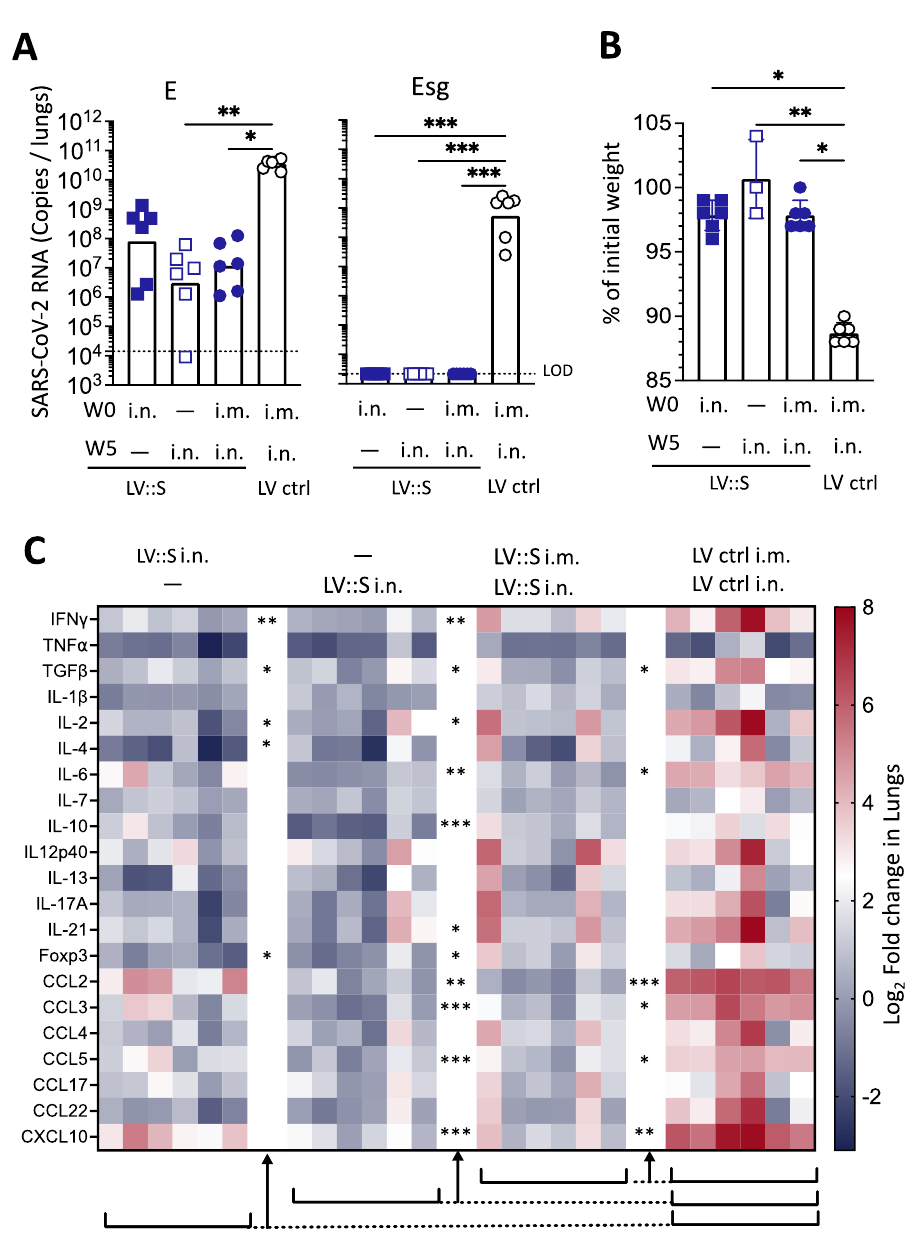
Figure 3. Single i.n. LV::S injection fully protects hamsters against WA1 SARS-CoV-2. Hamsters are those described in the legend to Figure 2. Hamsters were immunized either i.n. with 1 × 10 8 TU of LV::S at wk0 (blue squares) or wk5 (open squares) or i.m. at wk0 and i.n. at wk5 (blue circles). Black circles represent hamsters injected i.m. at wk0 and i.n. at wk5 with 1 × 10 8 TU of LV::ctrl. ( A ) Lung viral loads quantitated by total E ( left ) or Esg qRT-PCR ( right ) at 4 dpi. Bars represent geometric means. ( B ) Percentages of weight loss in LV::S- or LV ctrl-vaccinated hamsters at 4 dpi. ( C ) Expression of inflammatory cytokines in lung tissues after challenge. The heatmap recapitulates relative log 2 fold changes in the expression of inflammation-related mediators in LV::S vaccinated or LV ctrl- administered individuals, as analyzed at 4 dpi by use of RNA extracted from total lung homogenates and normalized versus samples from untreated controls. Six individual hamsters per group are shown in the heatmap. Statistical differences between LV:: S and LV ctrl groups were determined by the Kruskal–Wallis test followed by Dunn’s multiple comparisons test and are indicated by asterisks; * p < 0.05; ** p < 0.01; *** p < 0.001. Comparisons were made between vaccinated groups and LV ctrl.